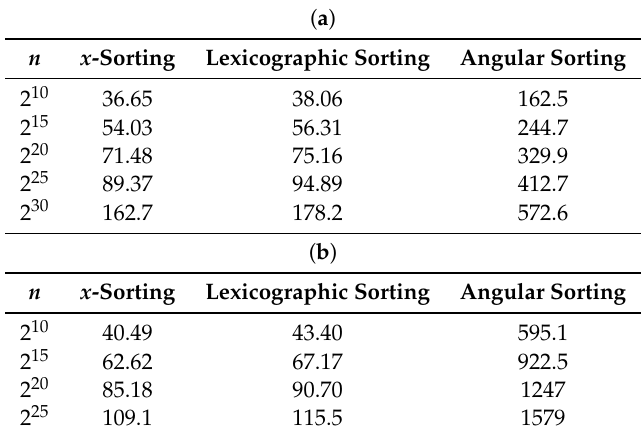
Table 2. Performance of INTROSORT for different comparators [nanoseconds per point] for the square data set: ( a ) Linux computer, ( b ) Windows